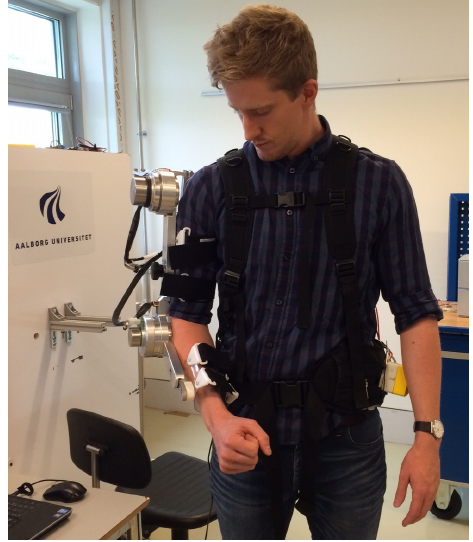
Figure 17: The built prototype of the UB-AXO oskeleton named UB-AXO. In the model, major factors that affect the physical human-robot interaction are duly considered. They cover the torques and reaction forces at the human joints and the power and energy consumption in the motion assistance. Moreover, the problem of physical contact between the exoskeleton and the human limb is addressed. The model allows us to estimate the dynamic behavior of the human- exoskeleton system and conduct comprehensive simu- lations to improve our understanding on the pHRI and to finally design an exoskeleton with optimized pHRI. Two cases were simulated, one for a bicep curl and the other for an overhead reach. The simulation results show that the use of the proposed exoskeleton can sig- nificantly reduce both the required maximum muscle activity, targeted human joint torques and muscle en- ergy consumption in the human arm. In our simulated study, the mean maximum muscle activity during the motions was reduced by 30% to 45% with the low-level assistance control and 33% to 62% for the high-level as- Figure 16: Maximum normal forces of the contact sistance control. The targeted joint torques, i.e. shoul- model nodes in: (a) upper arm cuff in bi- der abduction/adduction and flexion/extension and el- ceps curl study, (b) forearm cuff in biceps bow flexion/extension, were reduced by 40% to 81% curl study, (c) upper arm cuff in overhead with the low-level assistance control and 58% to 84% study, (d) forearm cuff in overhead study for the high-level assistance control. The largest re- ductions in joint torques and maximum muscle activ- ity were achieved in static postures, which is in good agreement with the selected control